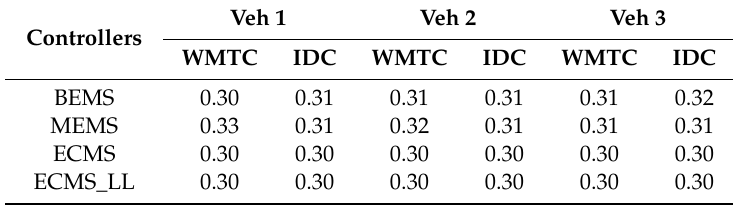
Table 4. Final SOC values for di ff erent vehicle configuration and drive